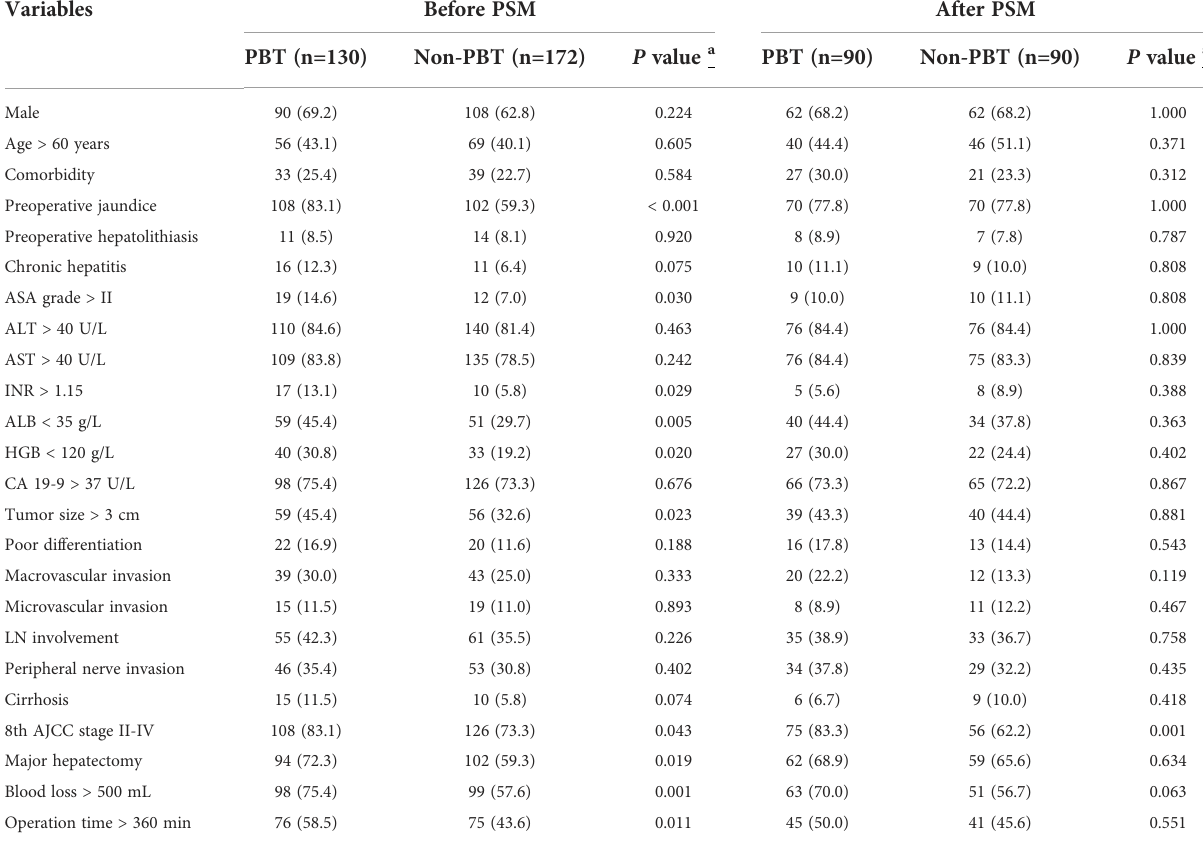
TABLE 1 Clinicopathologic characteristics of the PBT and non-PBT groups among all pCCA patients treated with curative resection. Variables Before